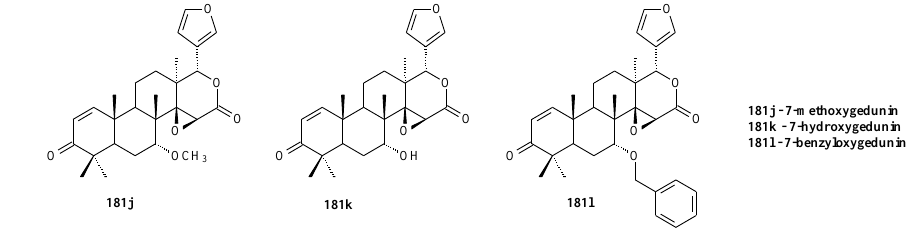
Figure 3. Gedunin ( 181 ) semi-synthetic derivatives [70].